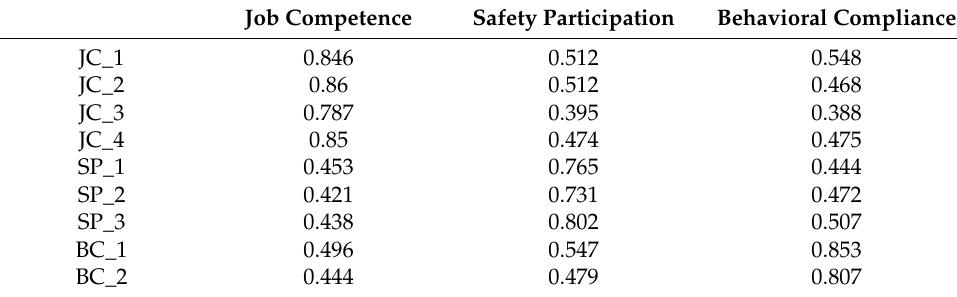
Table 6. Cross loadings criterion results.